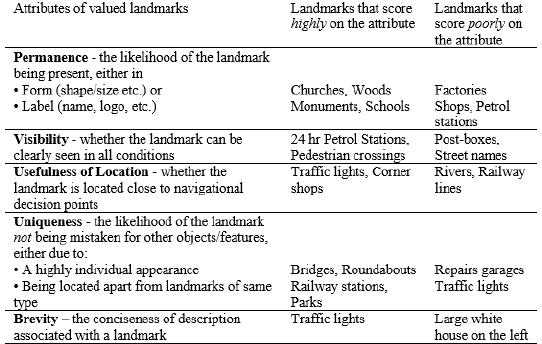
Figure 1. List of characteristics of the valued landmarks with examples of different landmarks for each characteristic that typically score high or poor ranking (source: Burnett et al.,